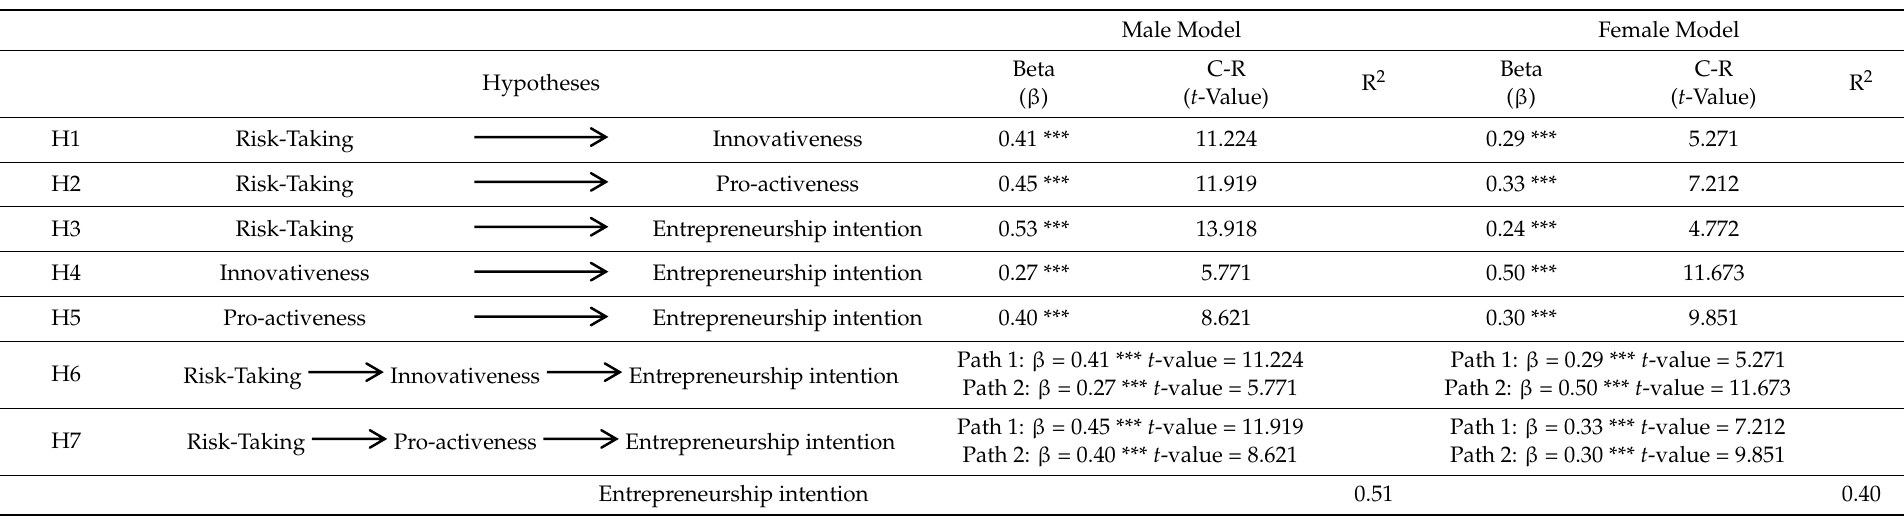
Table 3. The structural model’s results. Table 3. The structural model’s results . Table 3. The structural model’s results . Table 3. The structural model’s results . Table 3. The structural model’s results . Table 3. The structural model’s results . Table 3. The structural model’s results . Table 3. The structural model’s results Table 3. The structural model’s results . Table 3. The structural model’s results .